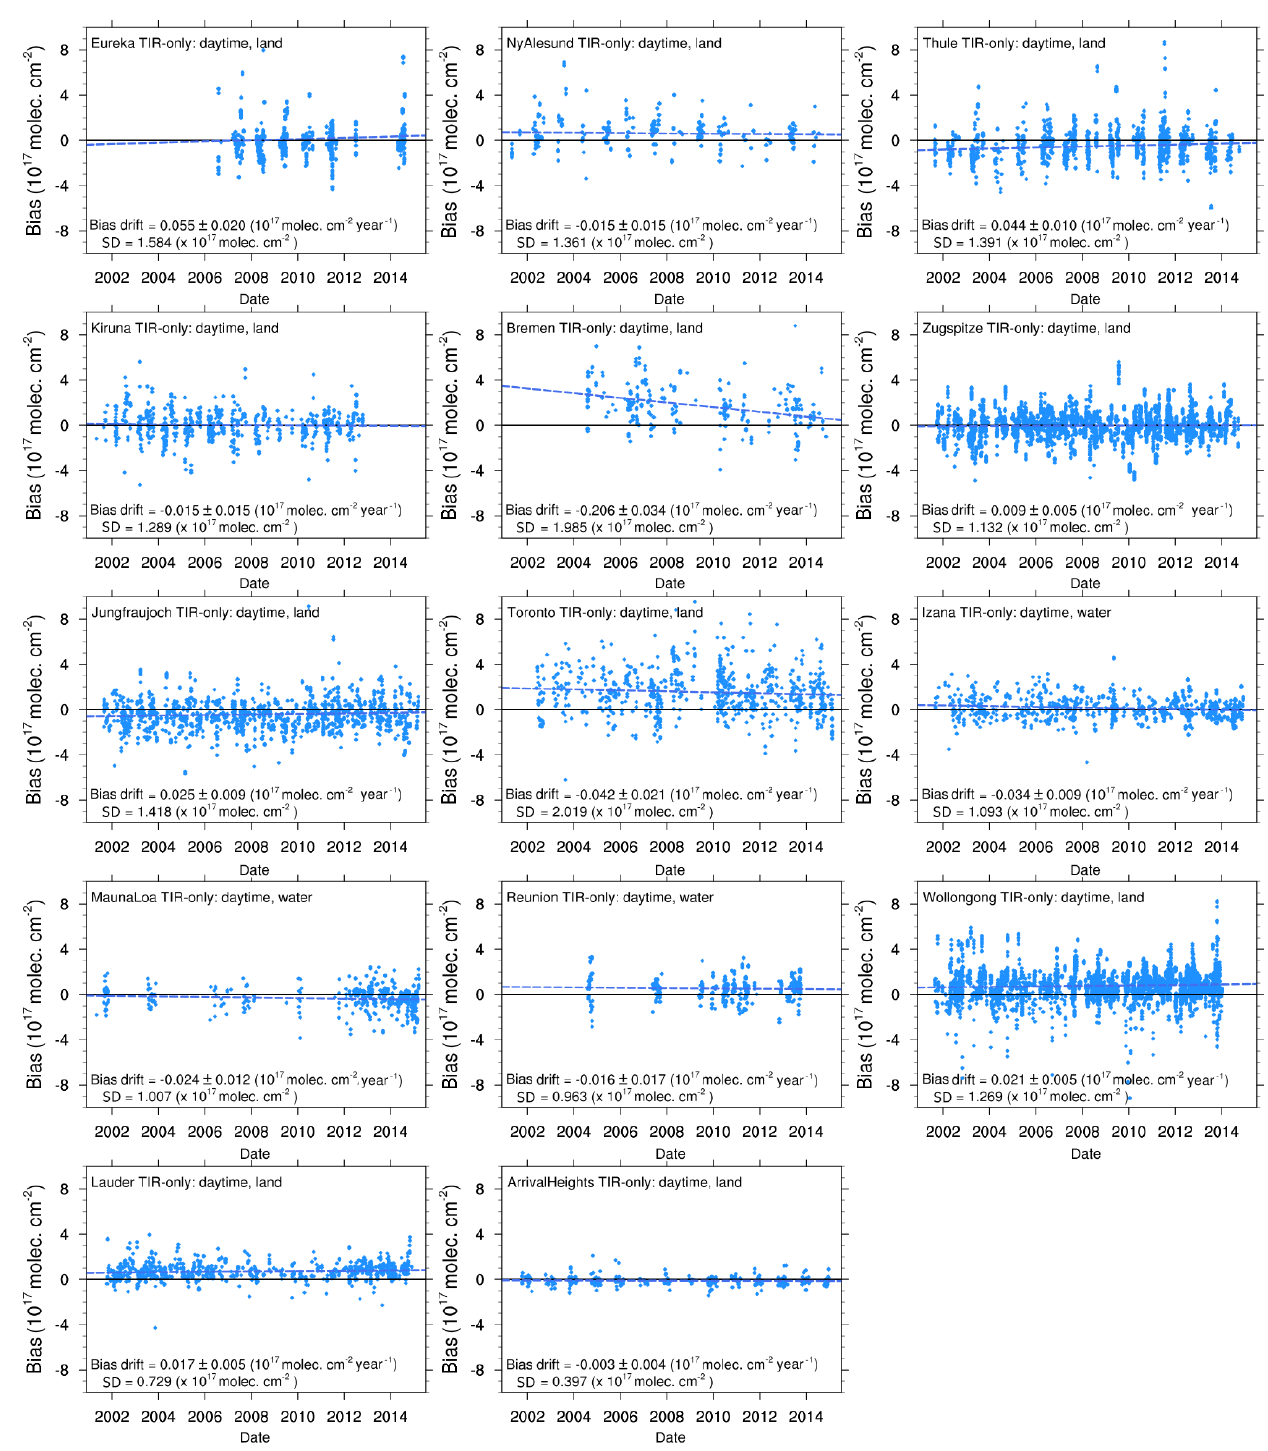
Figure A5. Temporal evolution of bias (MOPITT–FTS) at all stations for V6 TIR-only product. The blue dashed line indicates bias